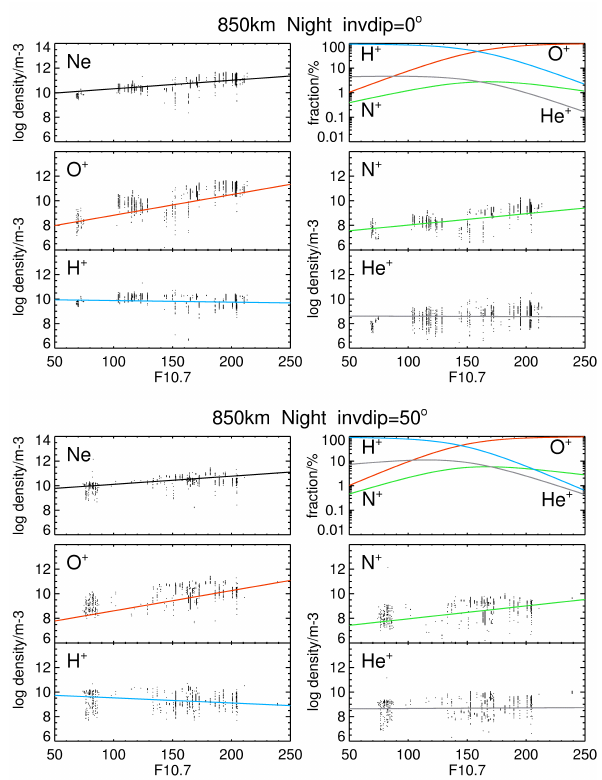
Fig. 5. Dependence of the logarithm of the individual ion densities, of the electron (=total ion) density, and of the relative ion densi- ties on the solar activity level characterized by the actual day val- ues of the F10.7 index. Example for equinox, equator ± 15 ◦ , mid- latitudes 50 ◦ ± 15 ◦ , altitude of 850 ± 90km, and daytime 13 ± 3h MLT. Points-measured values, lines-values calculated from the models (TTS relative ion density and electron density models).